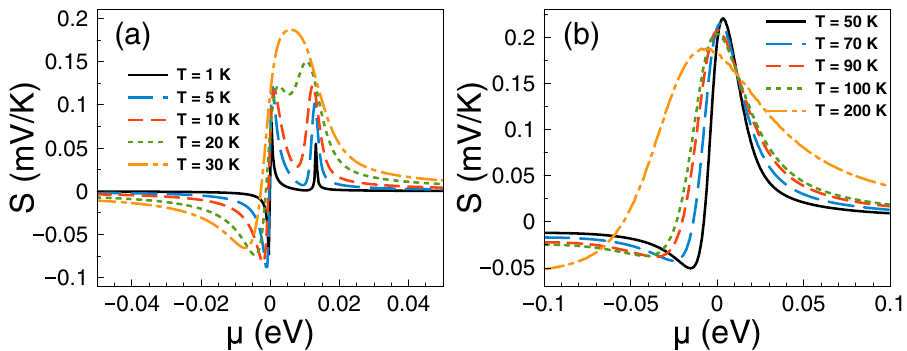
Figure 3. The Seebeck coefficient versus chemical potential for gapless bilayer graphene single barriers at different temperatures: (a) from 1 K to 30 K and (b) from 50 K to 200 K. The single barrier structural parameters are the same as in Fig. 2. As it is noted the charge neutrality point shapes the Seebeck coefficient characteristics at low temperatures, while the Fano resonances region become preponderant as the temperature rises.